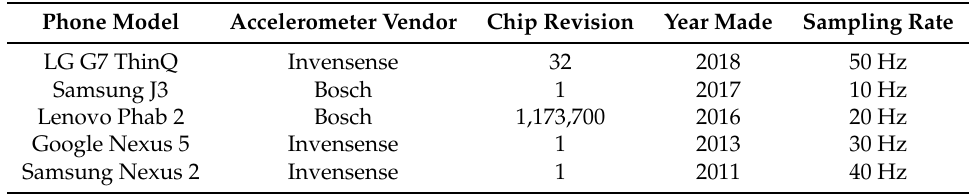
Table 3. Overview of the smartphones and the accelerometers used in the experiments: The LG G7 ThinQ was used for training, while the other four were used for testing.